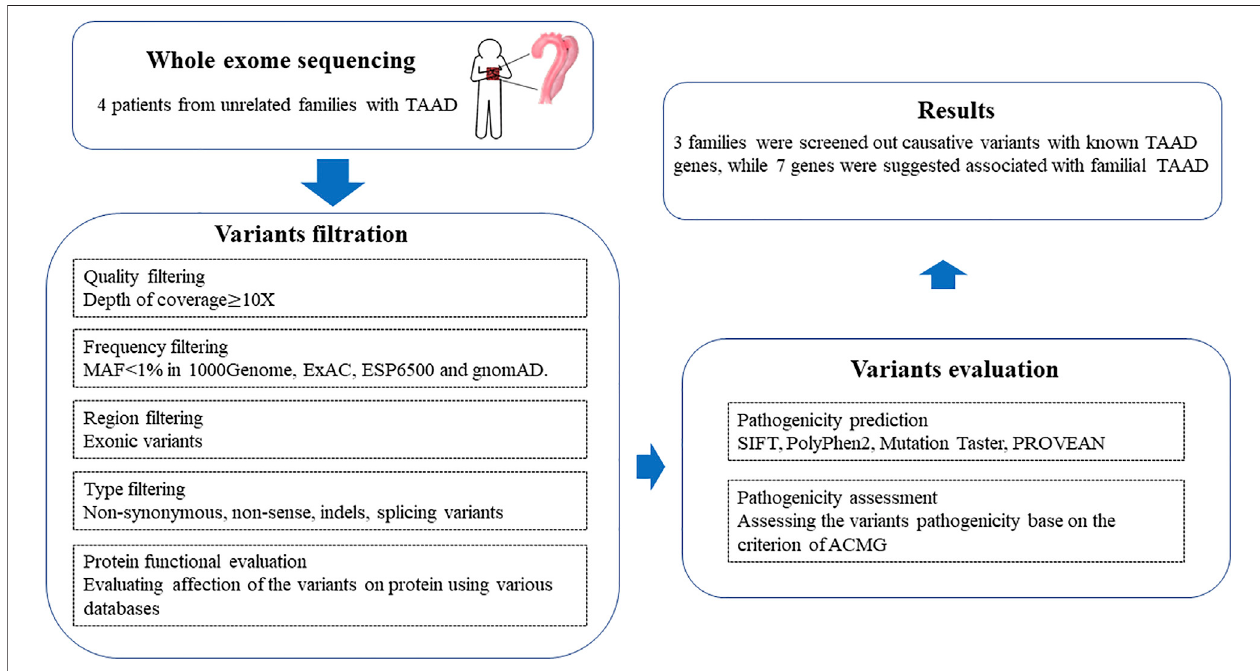
FIGURE 1 | Work fl ow of bioinformatics analysis in this study.